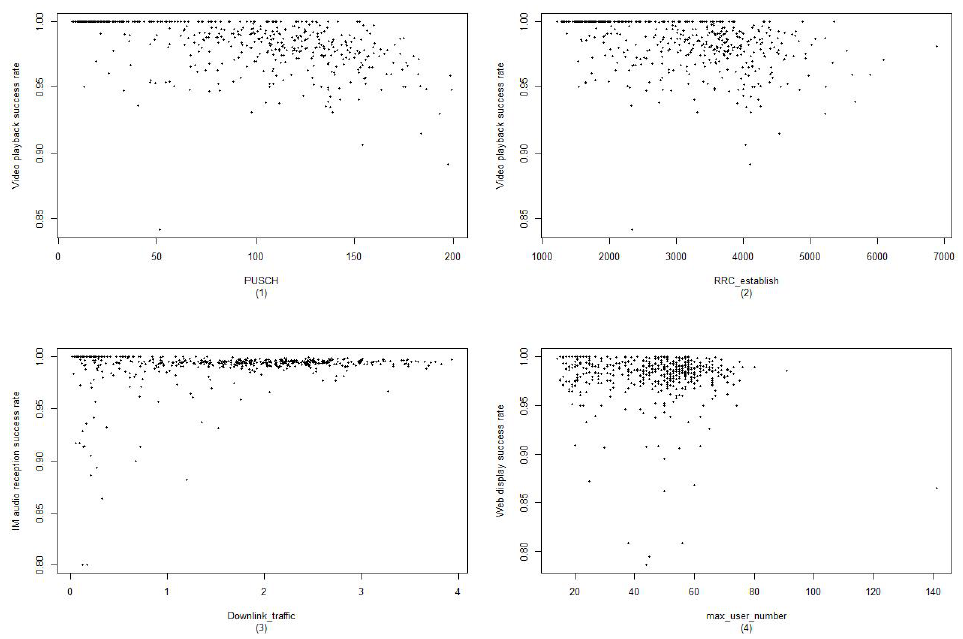
Figure 2. In Figure 2: (1) shows the corresponding relationship between the video playback success rate (KQI) and the PUSCH utilization rate (KPI) in the cell; (2) shows the corresponding relationship between the video playback success rate and the number of RRCs established in the cell; (3) shows the corresponding relationship between the IM audio receiving success rate and the downlink traffic in the cell; (4) is the corresponding relationship between the web display success rate and the max number of the cell. Table 3. Troubleshooting